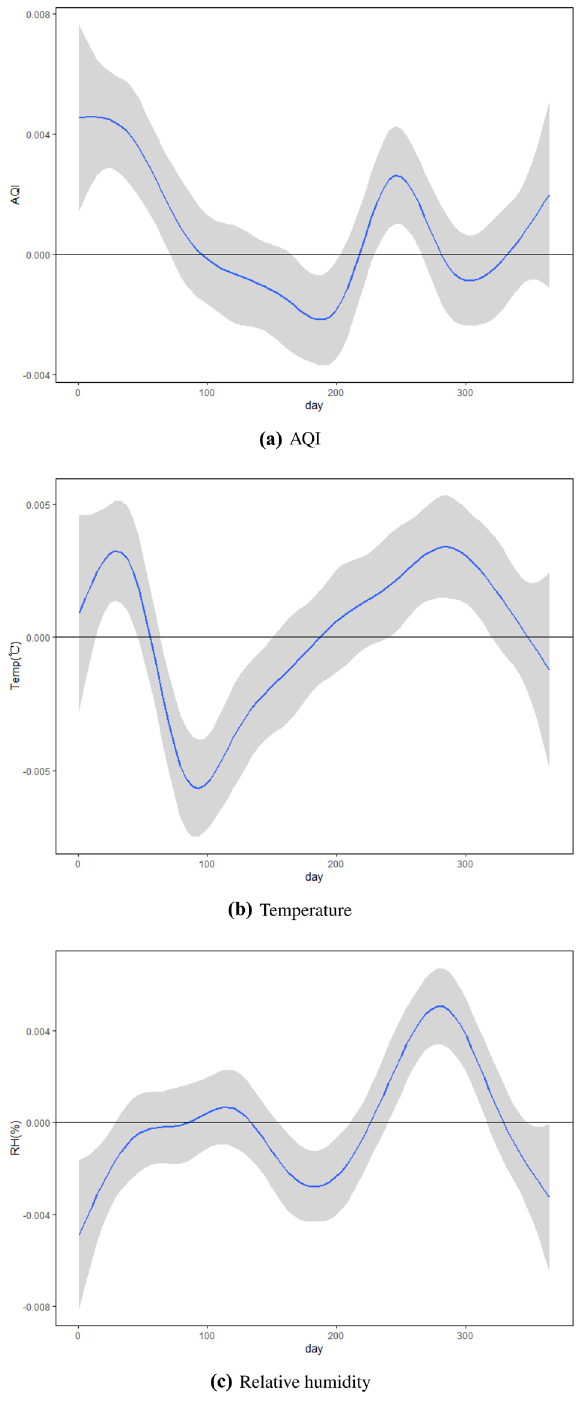
Figure 5. Regression coefficient function ˆ β( t ) and its 95% confidence